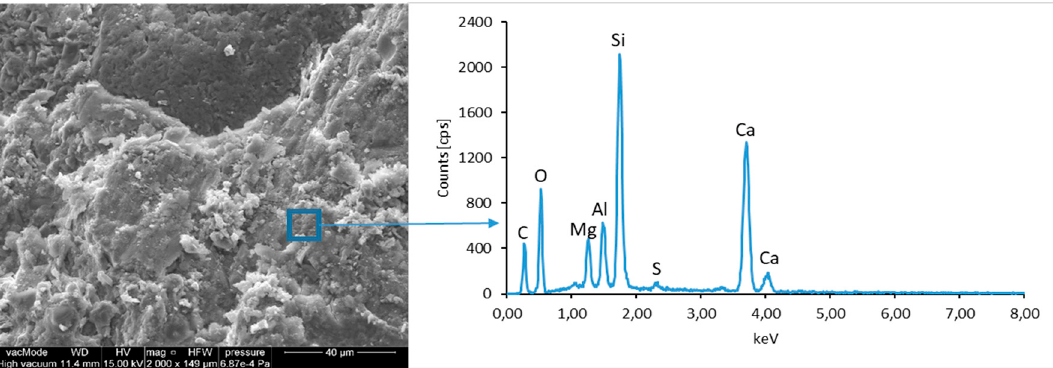
Figure 10. SEM micro-structure of an LCD panel and results of elemental analysis in EDS micro-area.